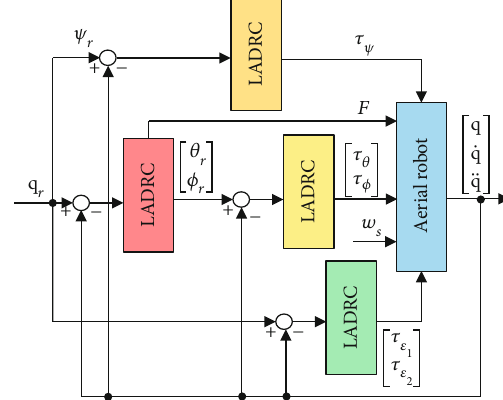
Figure 3: Control structure of the aerial